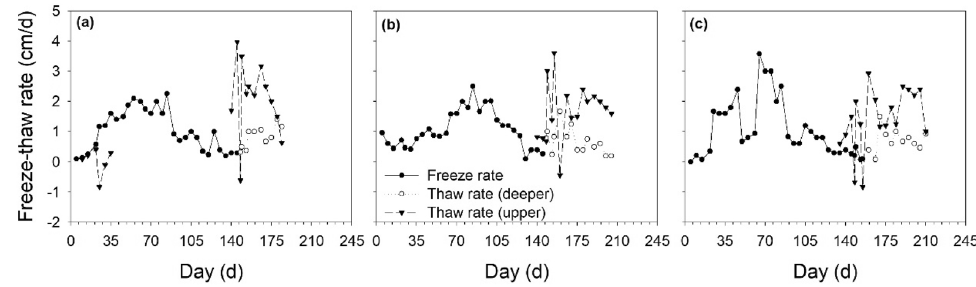
Figure 4. Soil freeze–thaw rate of farmland ( a ), LT grassland ( b ) and AS land ( c ).